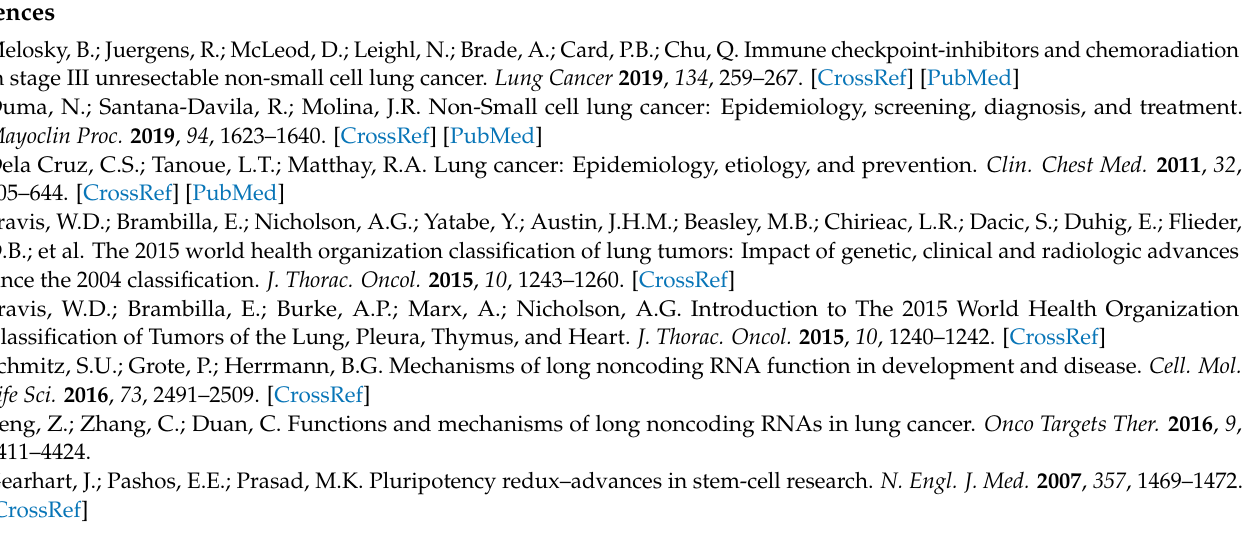
gene); Figure S2: Differential lncRNA survival analysis (A), differential miRNA survival analysis (B); Figure S3: Gene expression levels in paracancer tissues and cancer tissues of patients with differentially expressed genes (A) lncRNA, (B) miRNA, (C) mRNA; Figure S4: Correlation analysis of differentially expressed